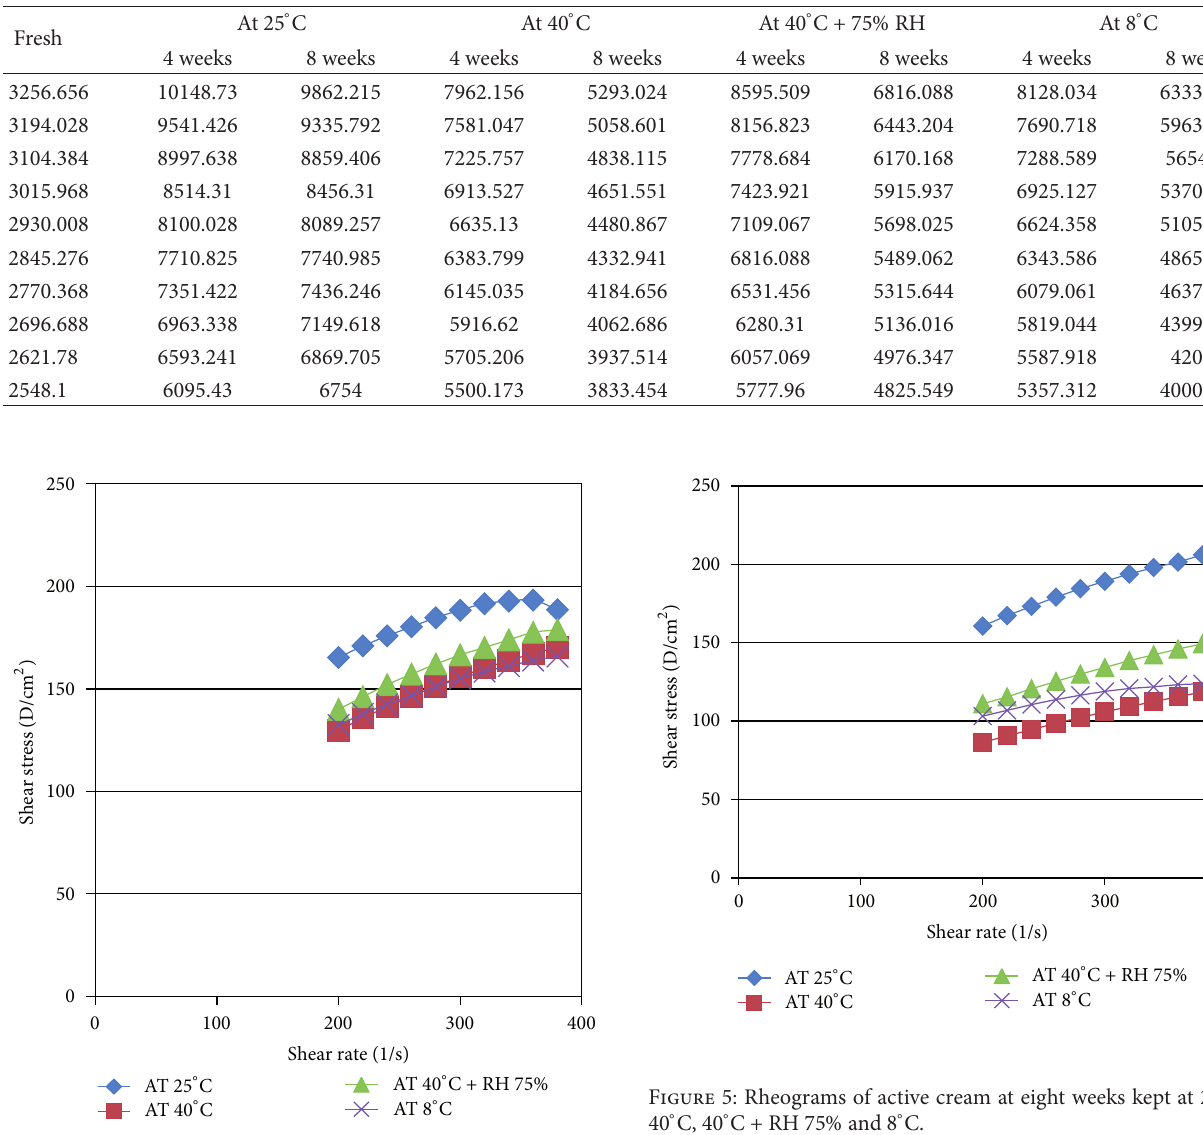
T 6: Viscosities (cP) of active cream at different temperatures and time intervals.